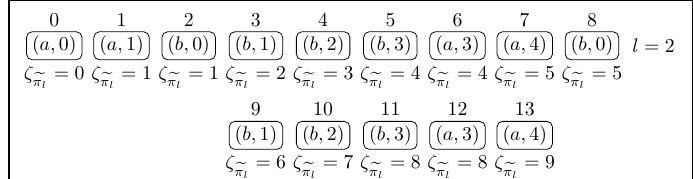
Figure 3. An example of the k -path, which is a